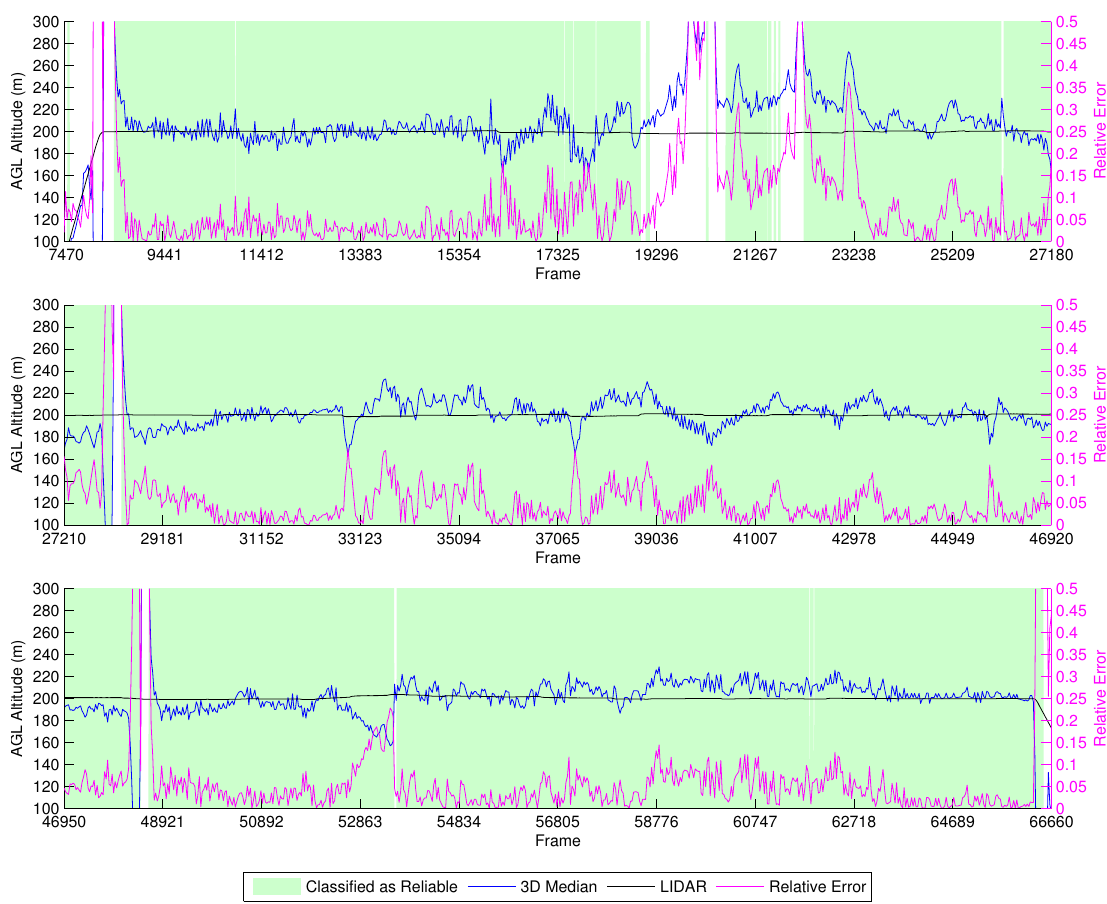
Figure 6. Height estimation results for the fixed AGL altitude at 200 m simulation.